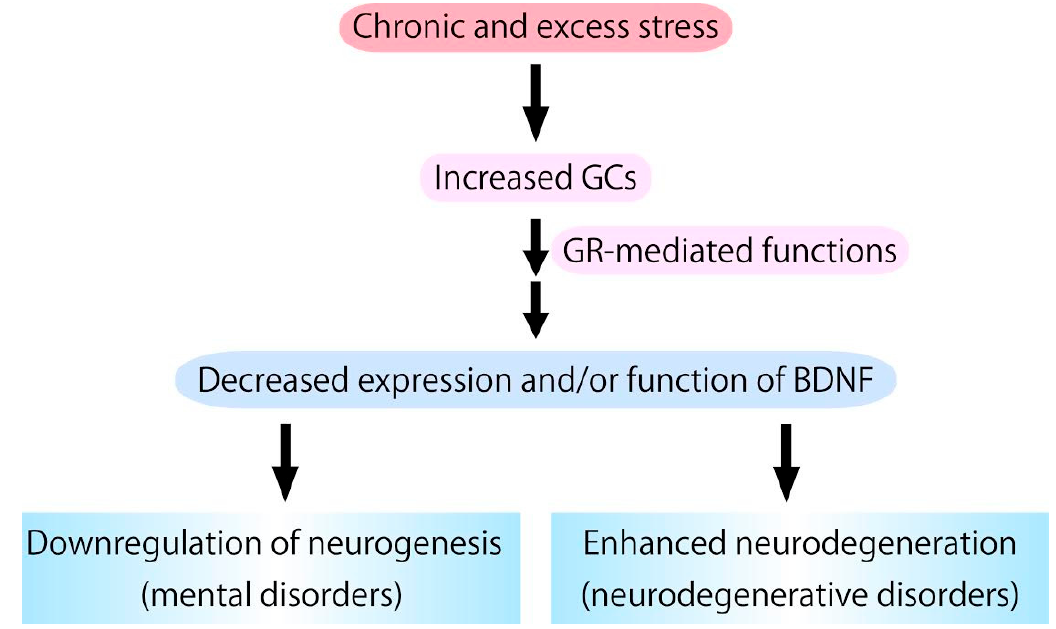
Figure 3. Chronic glucocorticoids (GCs) stress, which stimulates glucocorticoid receptor (GR) activation, causes downregulation of expression/function of BDNF. Because BDNF has pivotal roles in supporting neurogenesis and preventing neurodegeneration, it is possible that excess GCs functions as a negative factor in neurogenesis and a risk factor for the development/progression of neurodegenerative pathologies. Table 1. Actions of GCs on neurogenesis and BDNF expression.